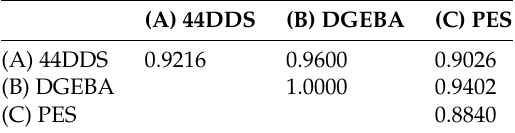
Table 1. Interaction strengths ( ε ij ) determined by cohesive energy